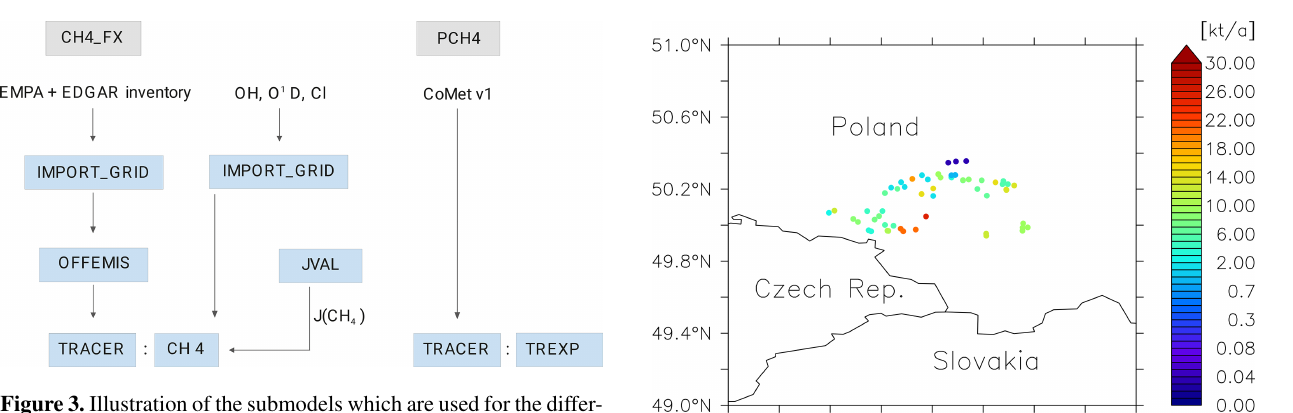
Figure 3. Illustration of the submodels which are used for the differ- ent methane tracers. CH4_FX tracer (left side): methane emission data and the oxidation reaction partners OH, O 1 D and Cl are read from the NetCDF files and transformed to the computational grid by the submodel IMPORT_GRID. OFFEMIS converts the emission fluxes into tracer tendencies, and the CH4 submodel simulates the chemical loss of methane using the predefined fields of the oxida- tion partners and the calculated photolysis rate from the submodel JVAL. PCH4 (right side): the submodel TREXP is used for the point source emissions and tracer definition.